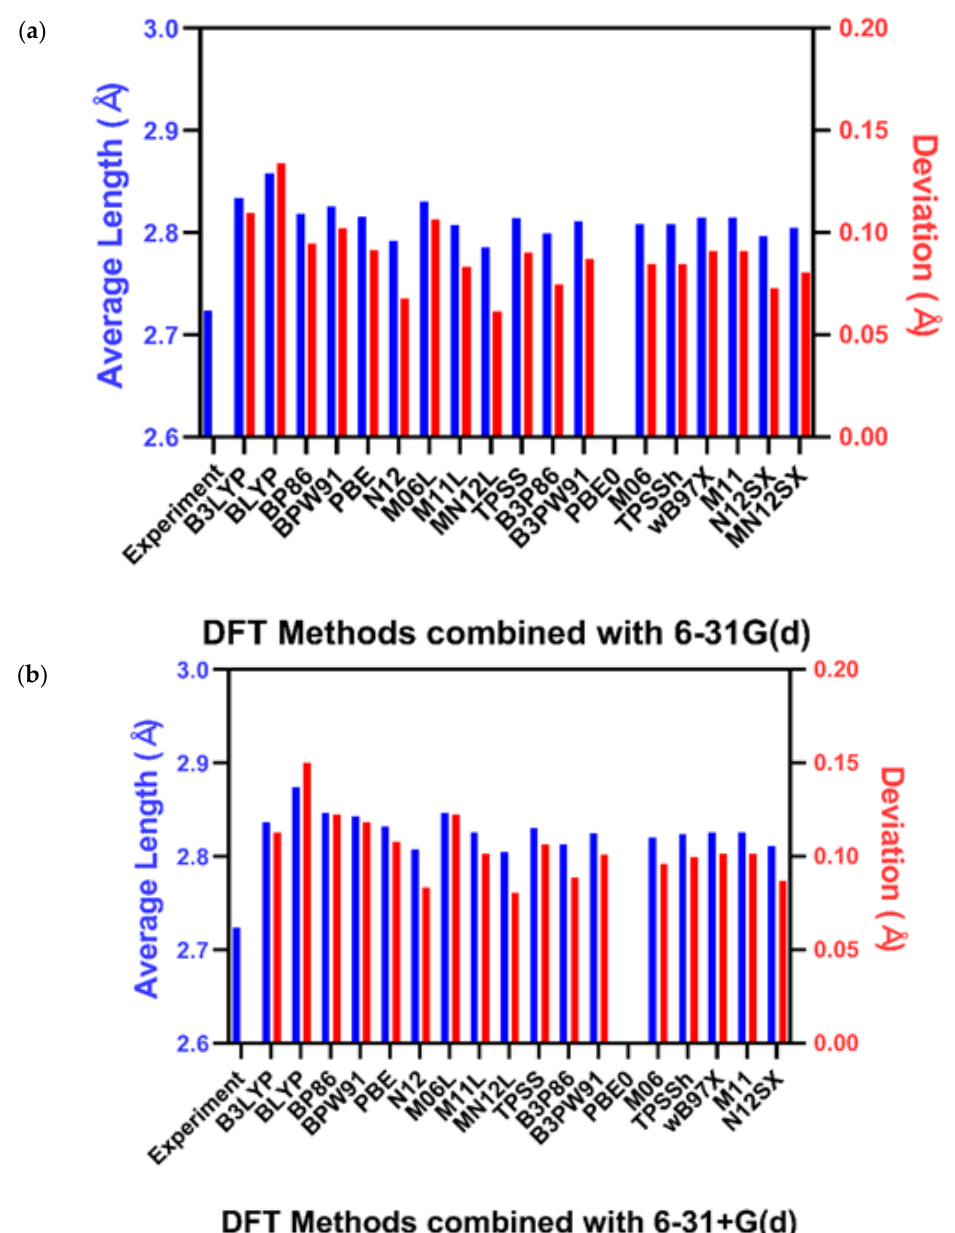
Figure 3. Average bond length of Am-Cl bonds in the optimized structure with ( a ) 6-31G(d) and ( b ) 6-31+G(d) [9].